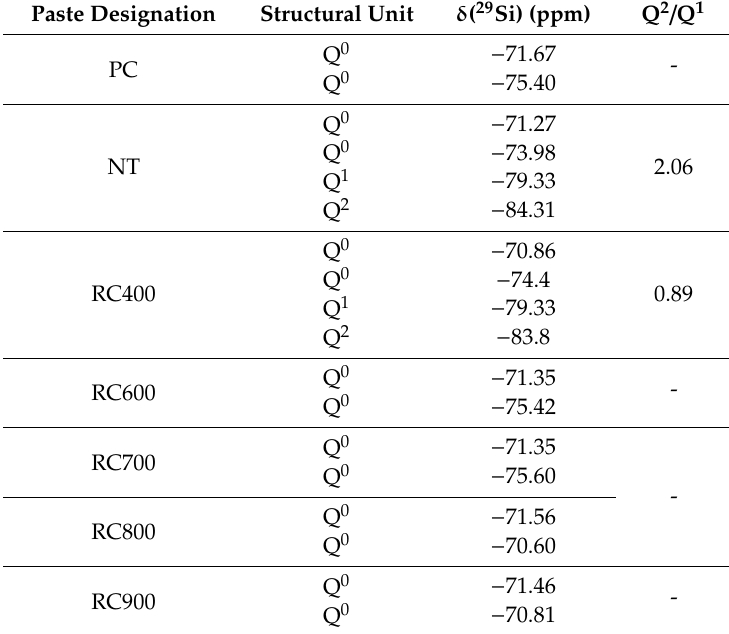
Table 4. Isotropic chemical shifts ( δ 29 Si) for PC, NT and RC treated at di ff erent temperatures. Paste Designation Structural Unit δ ( 29 Si)